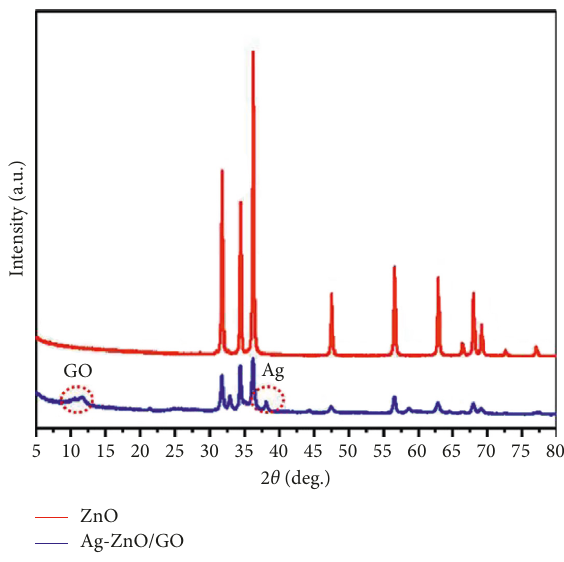
Figure 1: XRD patterns of the ZnO and Ag-ZnO/GO samples. Table 1: FWHM in the